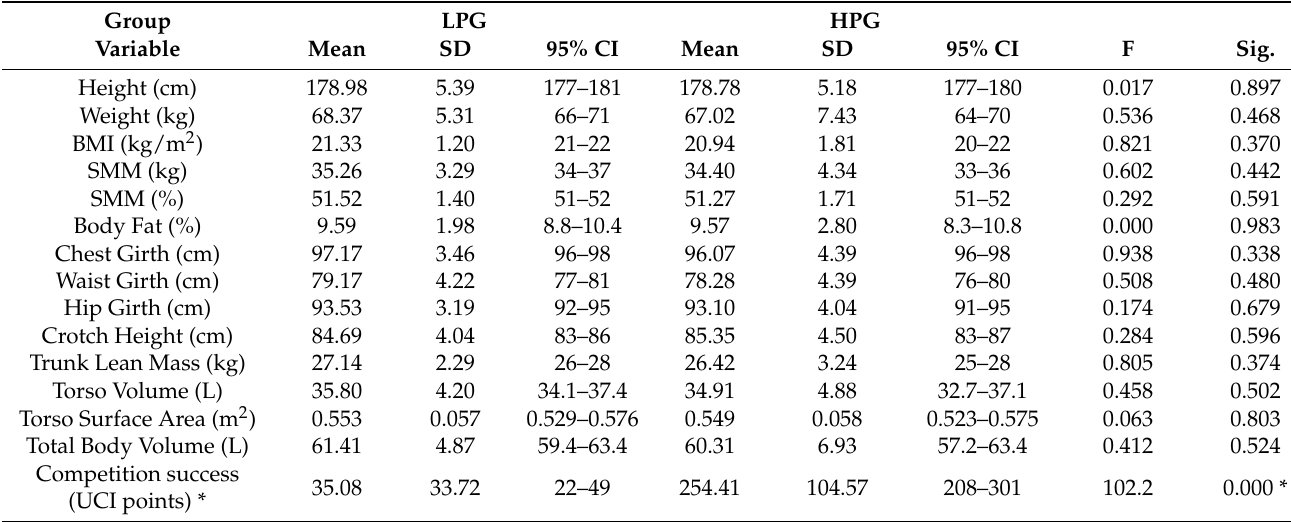
Table 1. One-way ANOVA with the descriptive presentation of the sample single morphological measurements with means ( ± SD) and 95% confidence interval (CI)